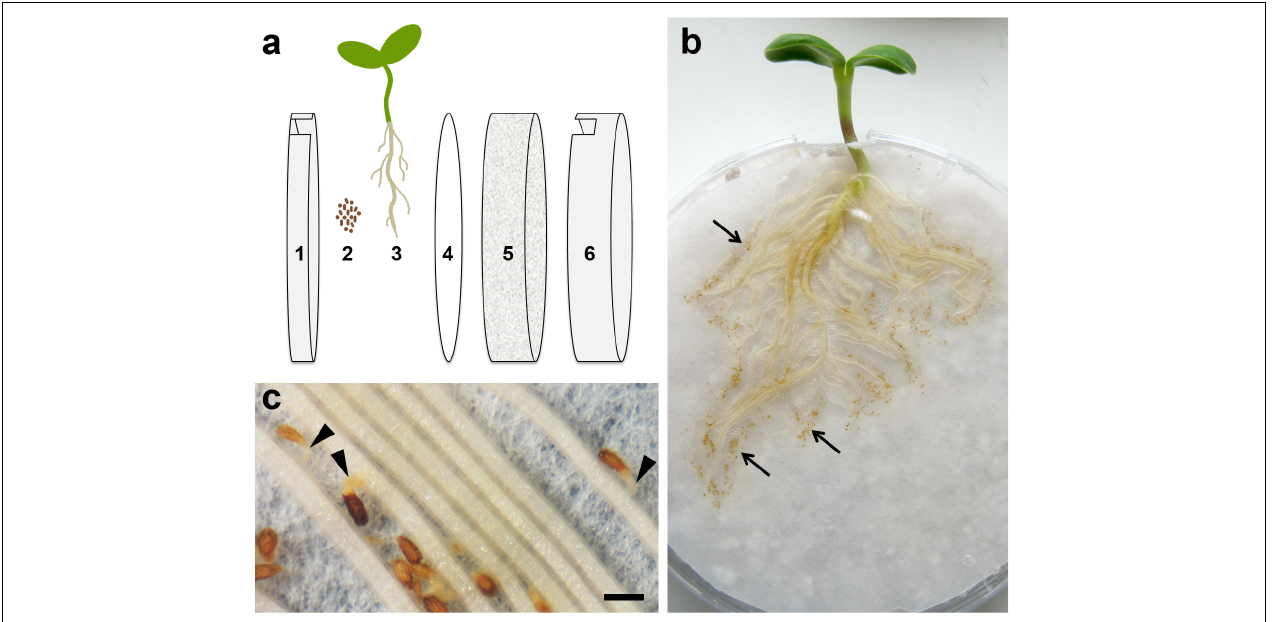
FIGURE 1 | Root chamber (rhizotron) cultivation system. (a) Technical setup: 1 – lid of Petri dish, 2 – surface-sterilized seeds of O. cumana , 3 – sunflower plant, 4 – filter paper, 5 – perlite, and 6 – bottom of Petri dish. (b) Root chamber with a 12-day-old sunflower plant and seeds of O. cumana (brownish points, arrows ) placed near the sunflower roots. (c) Germinated seeds of O. cumana with germ tubes ( arrowheads ) growing toward the host root. Scale bar = 500 µ